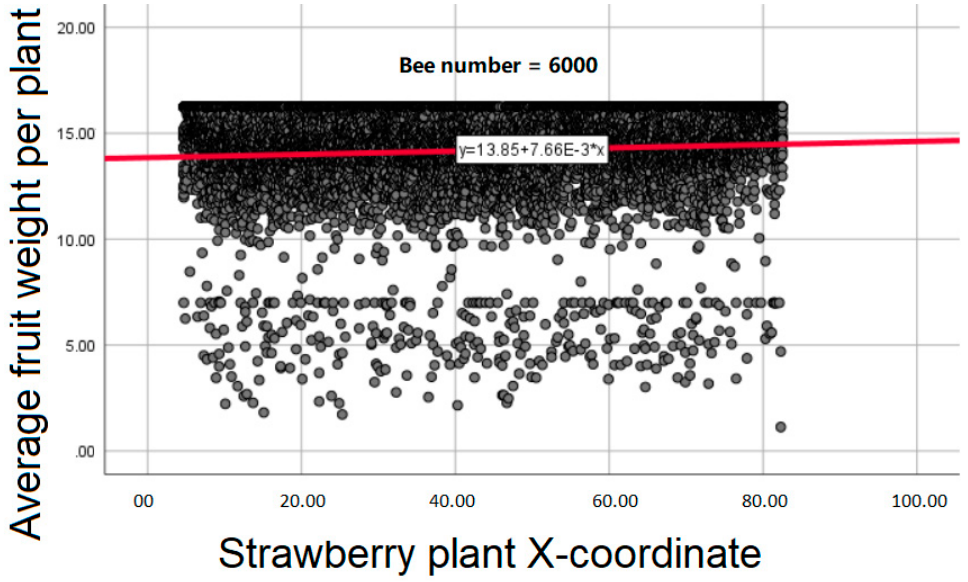
Figure 5. Diagram based on SPSS to show the relationship between strawberry plant X-coordinate and fruit quality. A high X-value represents a short distance to the hive located on the east side of the greenhouse.